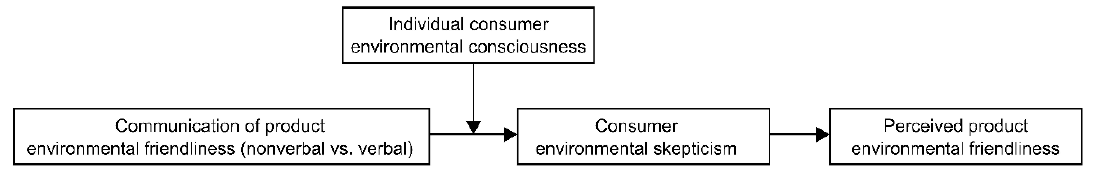
Figure 1. Model for first stage moderated, moderated mediation analysis. Note. Control variables (age, gender and product category involvement), fixed effect (participant), direct effects, and interactions between all independent variables on the dependent variables, consumer environmental skepticism and product environmental friendliness, are omitted for clarity.